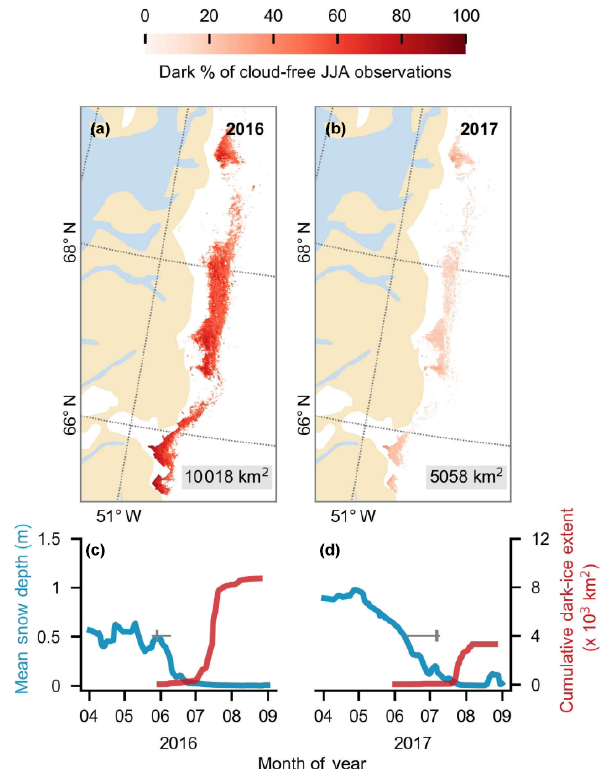
Figure 4. (a, b) Dark-ice duration on the south-western GrIS in summers 2016 and 2017, expressed as a percentage of the total daily cloud-free observations made during June–July–August (JJA). Each year is labelled with dark-ice extent. In each year, pixels that are dark for fewer than 5d are not shown. (c, d) Average snow depth modelled by MAR (blue) and cumulative dark-ice extent observed by MODIS (red) (Tedstone et al., 2017) during April to August. Vertical bars (grey) denote median date of snow clearing derived from MODIS. Horizontal bars denote the interquartile range of the day of year of bare ice appearance. Tick marks denote the start of each